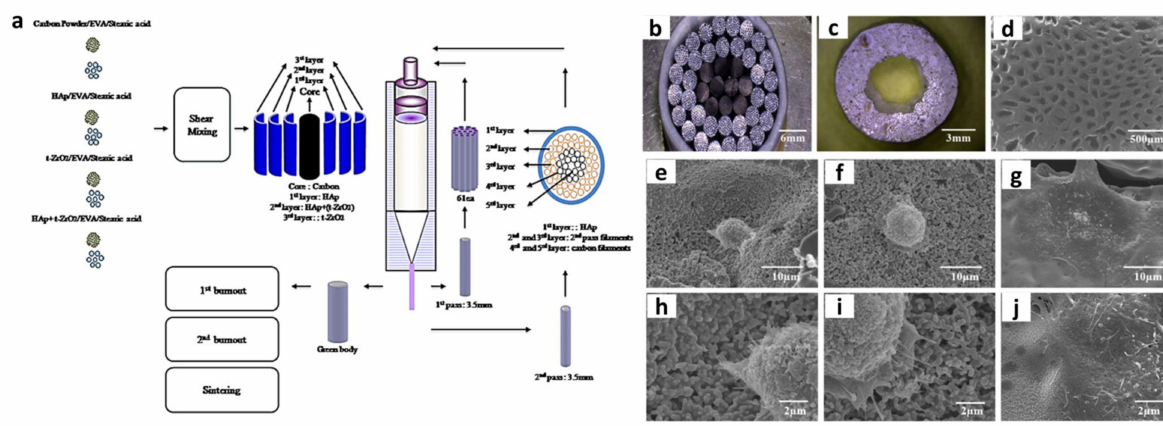
Figure 6. ( a ) Schematic of the multi-pass extrusion process. Photographs taken before extrusion and after sintering ( b ) arranged filaments and shell before final (3rd) extrusion, ( c ) sintered bodies at 1500 ◦ C, ( d ) enlarged SEM image of the pores. SEM images of MG-63 cell morphologies on TCP/TCP-(t-zirconia)/t-zirconia composites at incubation times of 15 min ( e , h ), 30 min ( f , i ) and 60 min ( g , j ). Images used from Lee et al. [76] reprinted with permission from Elsevier, copyright©